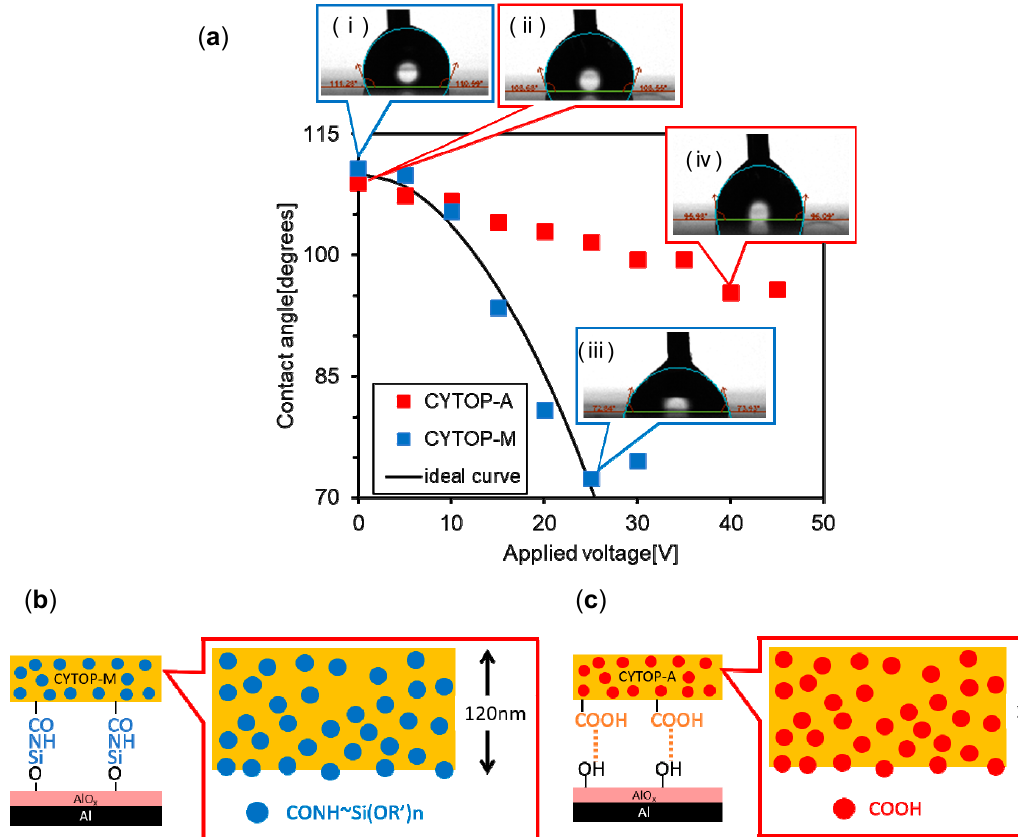
Figure 3. ( a ) Contact angles as functions of applied DC voltage for both CYTOP-A (red) (low polar terminal group) and CYTOP-M (blue) (high polar terminal group), increasing the voltage in 5 V increments. The black line indicates the ideal theoretical curve as calculated using the Young–Lippmann equation. (i) Initial contact angle image of CYTOP-M. (ii) Initial contact angel image of CYTOP-A. (iii) Contact angle image of CYTOP-M at applied 25 V. (iv) Contact angle image of CYTOP-A at applied 40 V. ( b ) Stacked CYTOP-M / AlO x / Al sample model, the interface of CYTOP-M / AlO x was covalently bonded. Blue dots show high polar functional terminal groups. ( c ) Stacked CYTOP-A / AlO x / Al sample model, the interface of CYTOP-A / AlO x was held together by hydrogen bonding. Red dots show low polar functional terminal